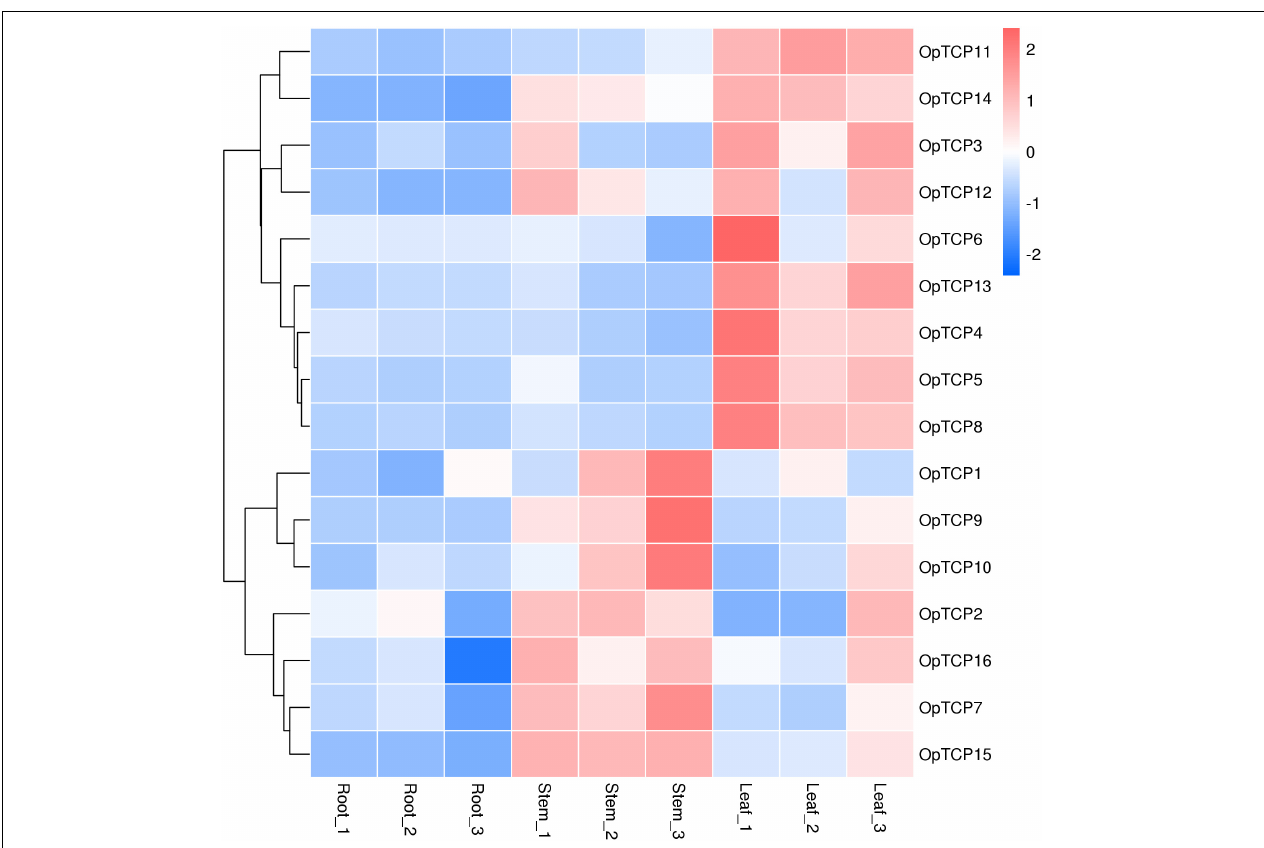
FIGURE 5 | Expression patterns of OpTCP genes in different tissues. TCP, teosinte branched 1/cycloidea/proliferating cell factors 1/2; OpTCP, O. pumila